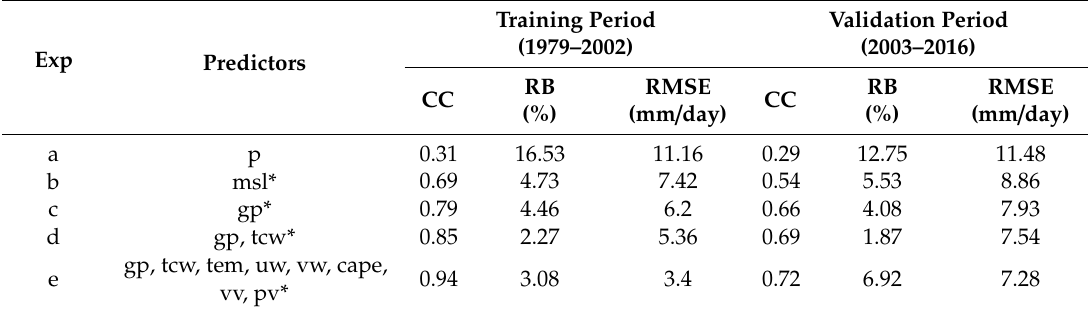
Table 2. Performance of downscaled precipitation using di ff erent predictors.